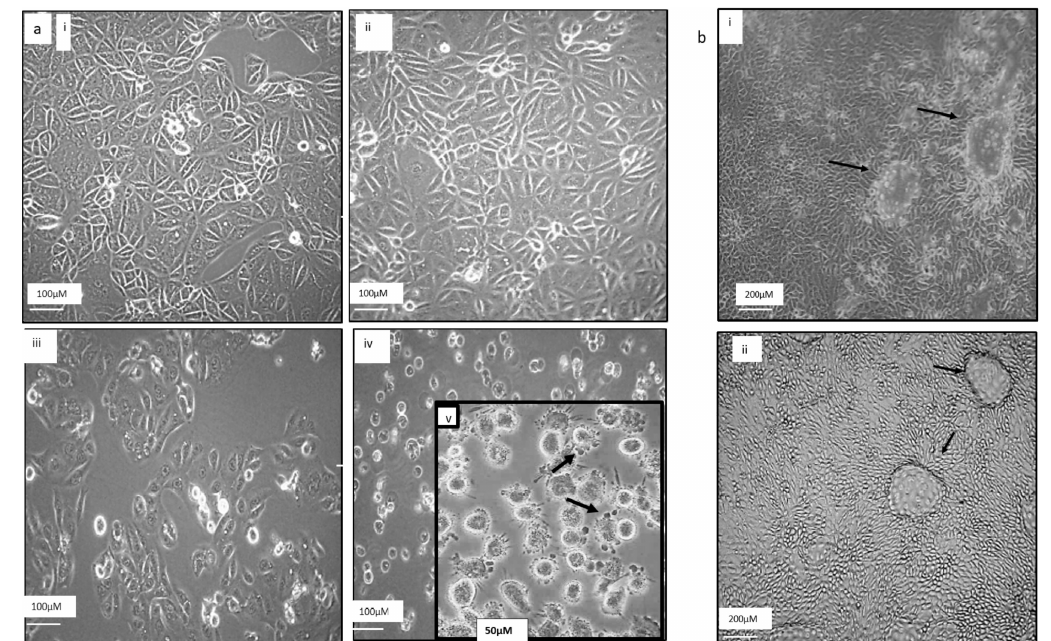
Figure 3. E ff ects of curcumin and TRAIL on the cell morphology ( a ) ACHN cells were treated with ( i ) culture medium contains 0.05% DMSO, ( ii ) 50 ng / mL TRAIL, ( iii ) 25 µ M curcumin or ( iv ) 50 ng / mL TRAIL plus 25 µ M Curcumin. ACHN cellular morphology was assessed using phase contrast microscopy under 100 × magnification (scale 100 µ M). ( v ) Higher magnification (identified bleb-like protrusions or “apoptotic bodies” (scale 50 µ M). ( b ) RPTEC / TERT1 cells were cultured on six-well plates for 10 days to allow di ff erentiation before treatment with ( i ) culture medium contains 0.05% DMSO only or with ( ii ) 50 ng / mL TRAIL plus 25 µ M curcumin. The e ff ects on cellular morphology were assessed. The arrows indicate the presence of fluid-filled dooms which reflect the establishment of an intact and functioning transport system within the cells and acts as an indicator of the overall RPTEC / TERT1 health (scale 200 µ